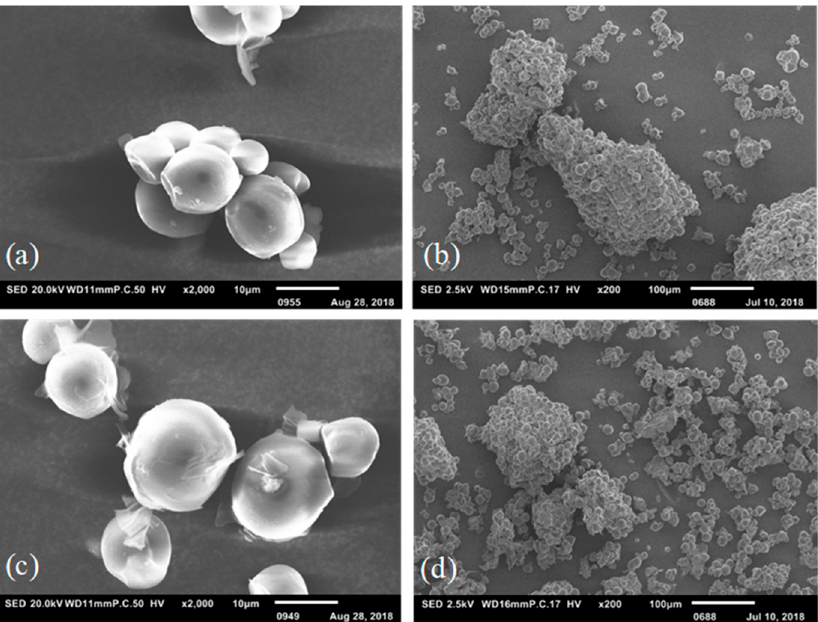
Figure 4. Scanning electron micrographs corresponding to peeled cassava tubers ( a , b ) with FTP using the peeling machine at optimum conditions and ( c,d ) manually peeled cassava tubers.